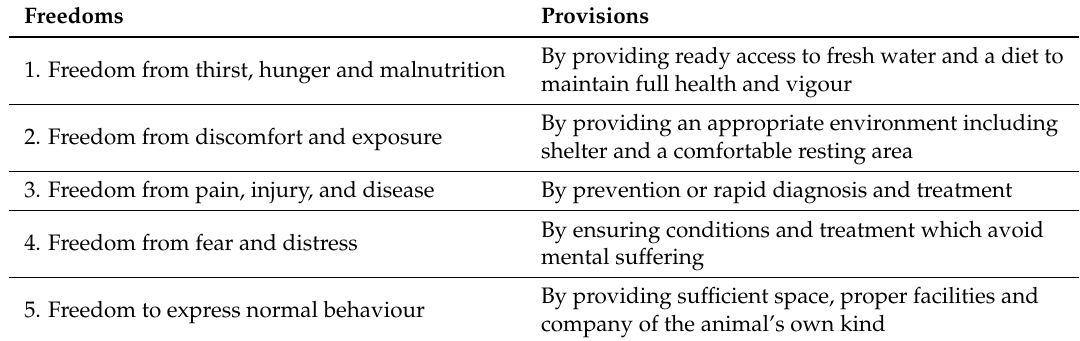
Table 1. The Five Freedoms and Five Provisions for promoting farm animal welfare